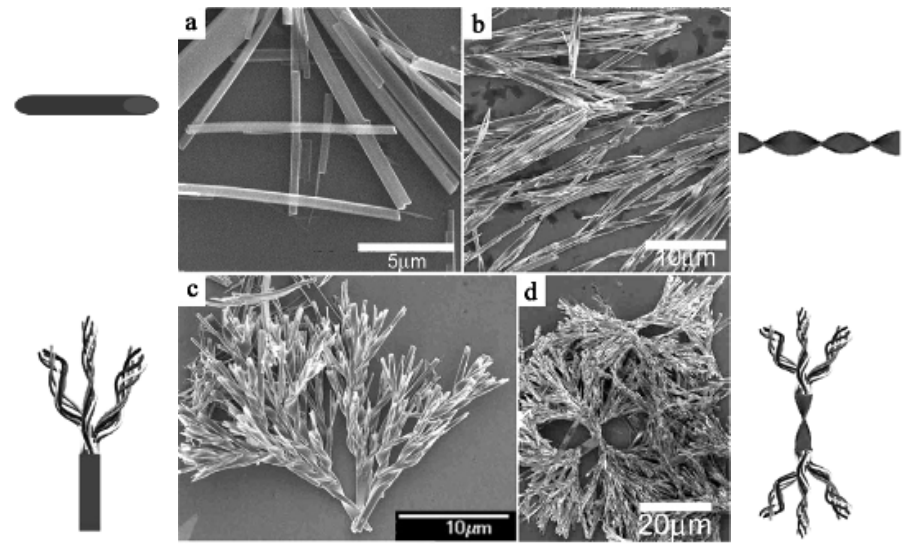
Figure 3. SEM images of TTF • TCNQ complex morphologies as prepared at the drip